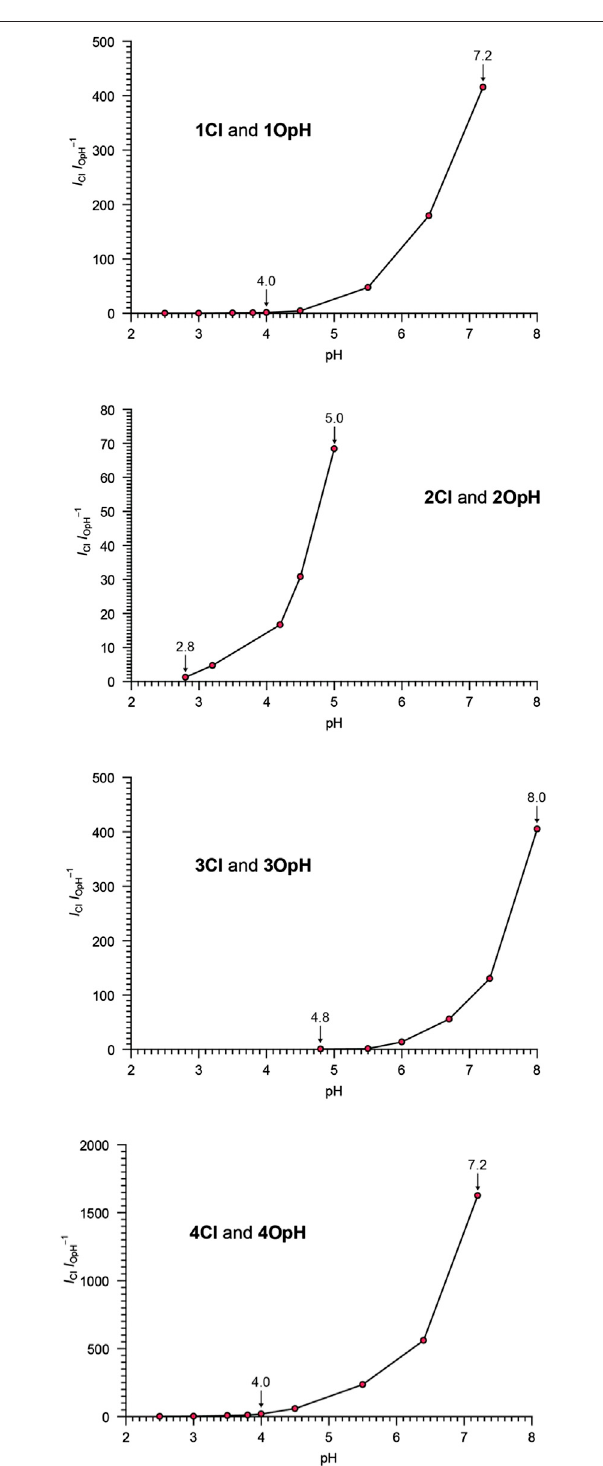
FIGURE4| pHdependenceoftheratiobetweentheemissionintensities of Cl and OpH ( λ Ex (cid:1) 405 or 575 nm) for aqueous solutions of 1 – 4 (2 – 8 µM) and Pluronic 123 (1.5 mg ml − 1